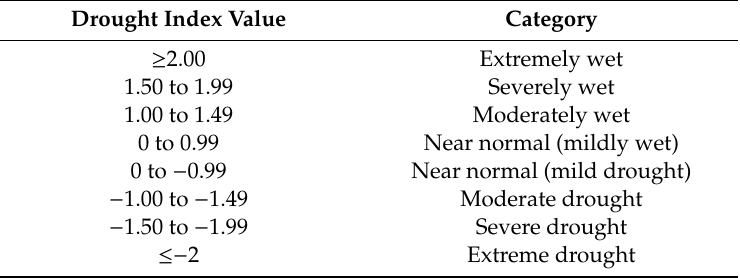
Table 1. Classification of drought conditions according to standardised precipitation index (SPI), agricultural SPI (aSPI) and standardised forms of reconnaissance drought index (RDI st ) and e ff ective RDI (eRDI st